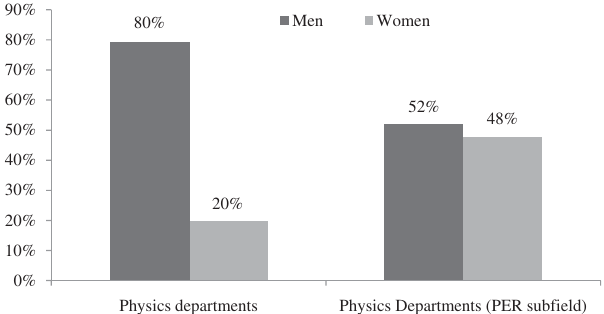
FIG. 1. Gender representations of graduate students in